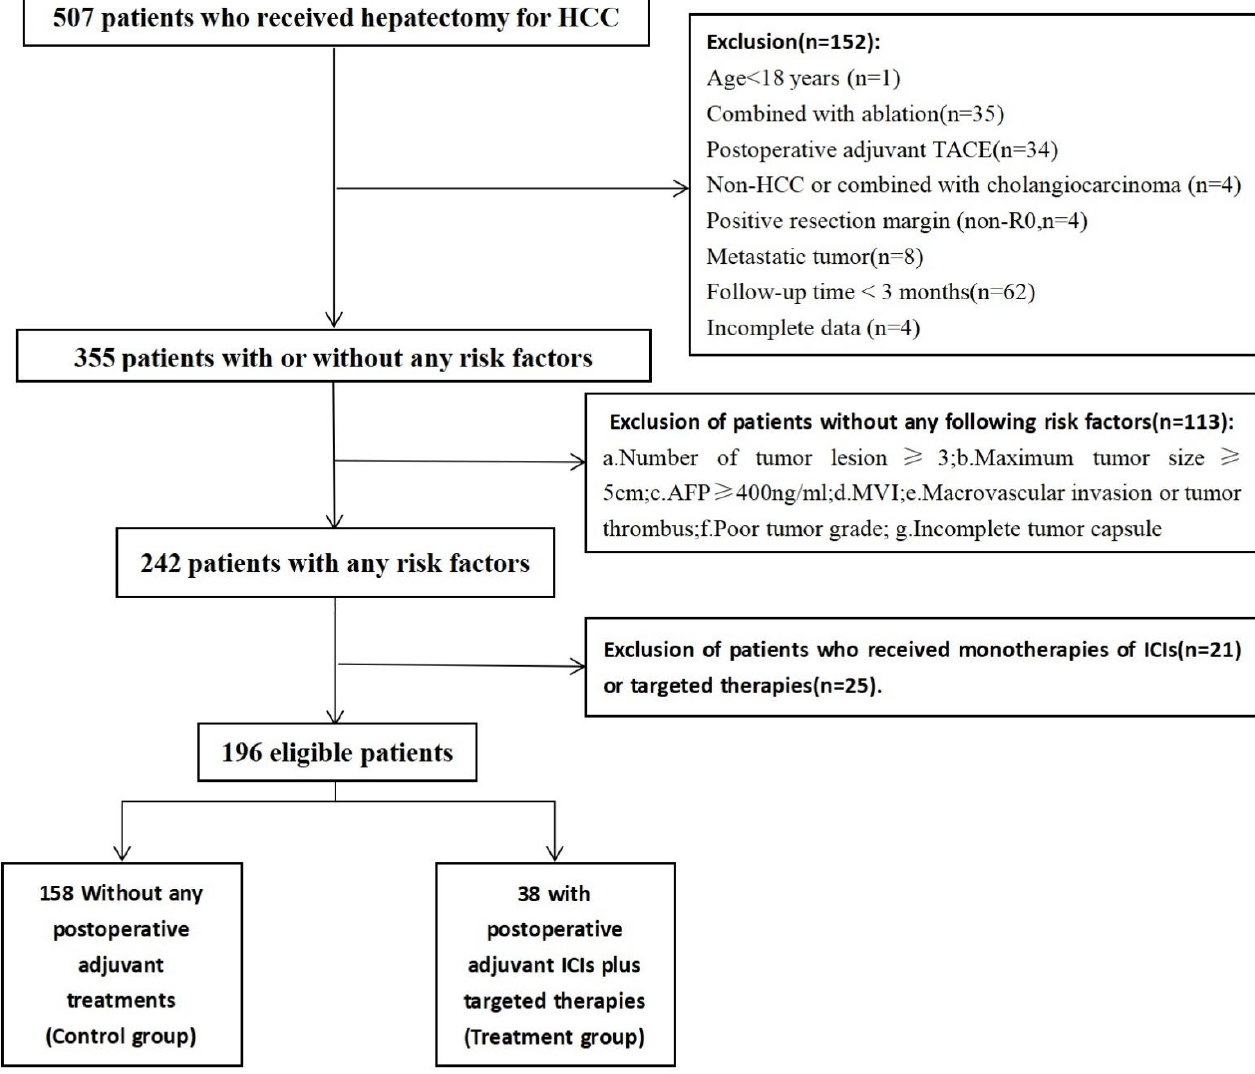
Figure 1. Patients flow diagrams. HCC = Hepatocellular carcinoma; TACE = Transarterial chemoem- bolization; AFP = Alpha-fetoprotein; MVI = Microvascular invasion; ICIs = Immune Checkpoint In- hibitors.